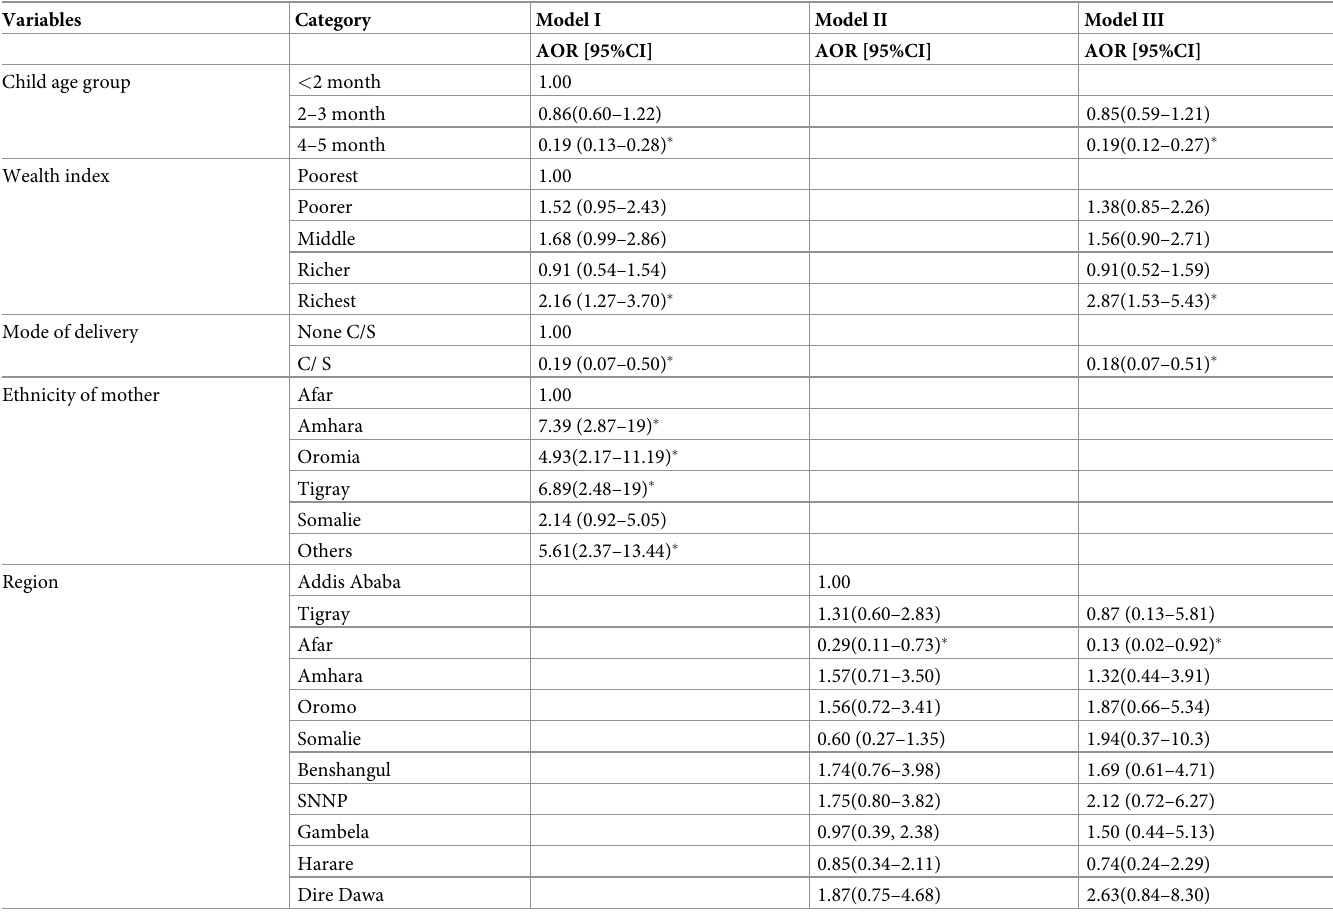
Table 4. Individual and community-level factors associated with OBF among 0-5-month-old children, Ethiopia 2016 (n =